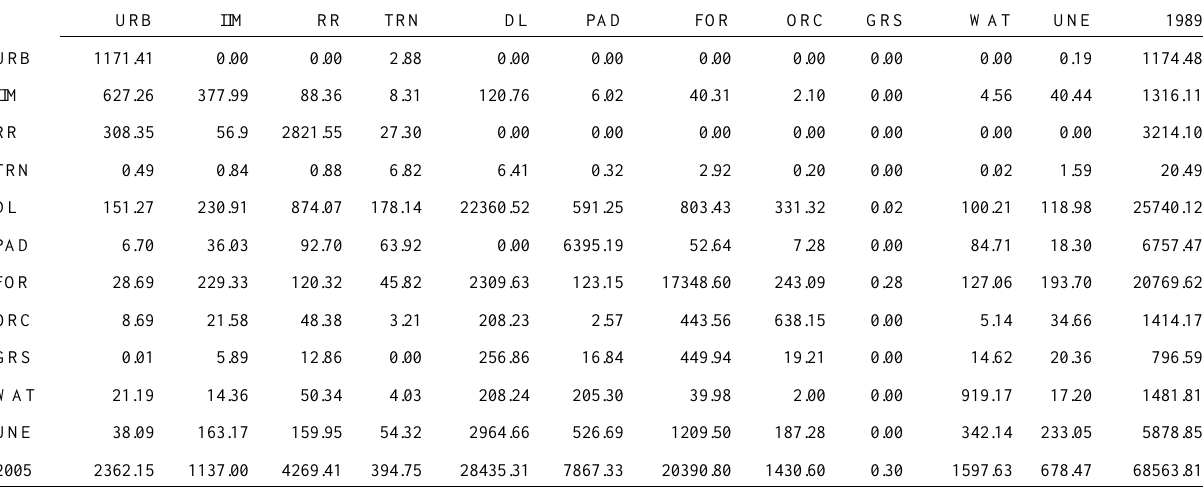
Table 4. Land use change matrix in Chuanying district between 1989 and